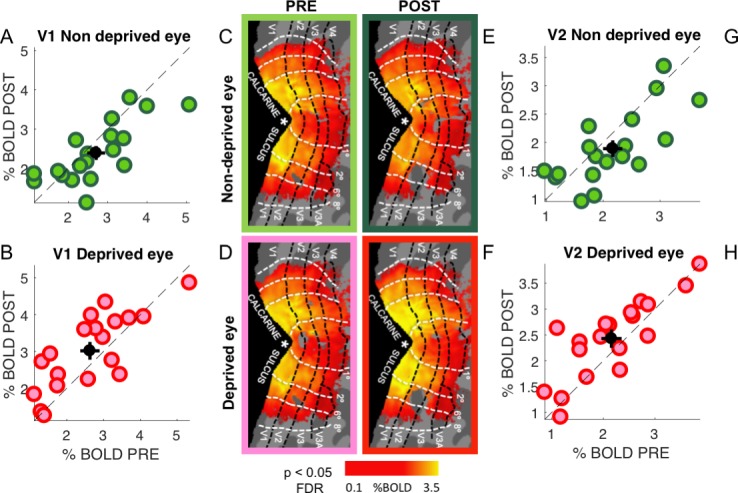
Effects of deprivation across the visual cortex Monocular deprivation had strong and opposite effects on the response to the 2.7 cpd stimulus in the two eyes.Panels in the top row report responses to the non-deprived eye, those in the bottom row to the deprived eye. The central panels map the average %BOLD response to stimuli presented in either eye, before and after monocular deprivation (isoeccentricty lines are taken from the pRF mapping shown in Figure 5A main text), showing that suppression of the non-deprived eye and enhancement of the deprived eye are largely homogeneous within each ROI. Panel A and G compare % BOLD responses in each of our 19 individual participants (each point shows the average across the two hemispheres), to stimuli in the non-deprived eye, before vs. after deprivation; the majority of points lie below the bisection of the axes, implying a reduction of responses to the non-deprived eye after monocular deprivation. The same comparison for stimuli in the deprived eye in panels B and H shows an increase of BOLD responses: most point lie above the bisection line, implying a boost of responses to the deprived eye after deprivation.